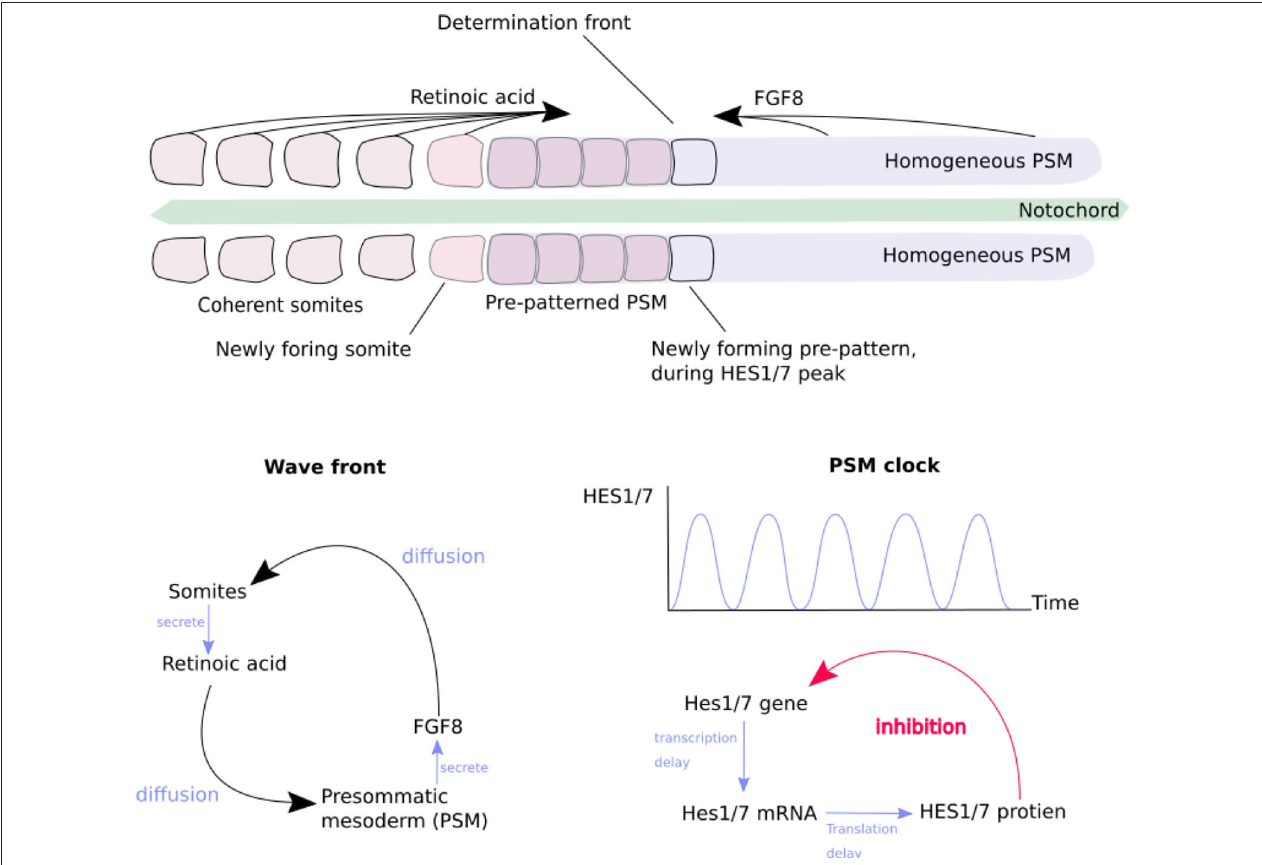
FIGURE 2 | The generation of somites by the “clock-and-wavefront” mechanism of morphogens. Redrawn from Baker et al. (2008) ( Figure 1 ). (Top) The progression of somite formation in the pre-somatic mesoderm (PSM) ( Box 2 ) either side of the notocord, in early morphogenesis of a vertebrate embryo. Opposing morphogen diffusion gradients define the “determination front” which is capable of forming a new somite. (Bottom left) The generation of the morphogen gradient by reciprocal stimulation of PSM and somites. (Bottom right) The generation of the “somitogenetic clock” in the PSM, by delayed